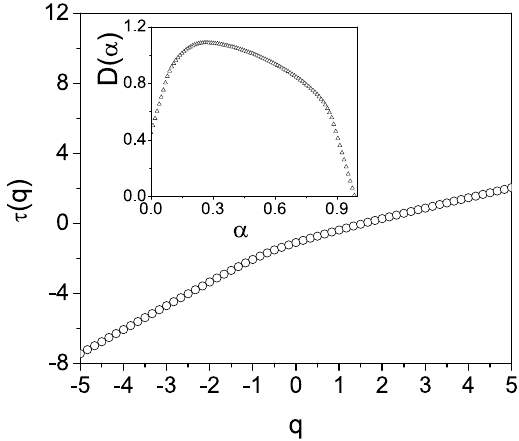
Figure 10. Scaling exponent τ ( q ) of the optical transmission of a Rudin-Shapiro structure (1024 layers). The inset shows the corresponding singularity spectrum α D ( ) calculated numerically with a Legendre transform of τ ( q ). The wavelet transform WT u s ( , ) of the optical transmission was computed using an analyzing wavelet ψ = − θ ′′ where θ is a Gaussian